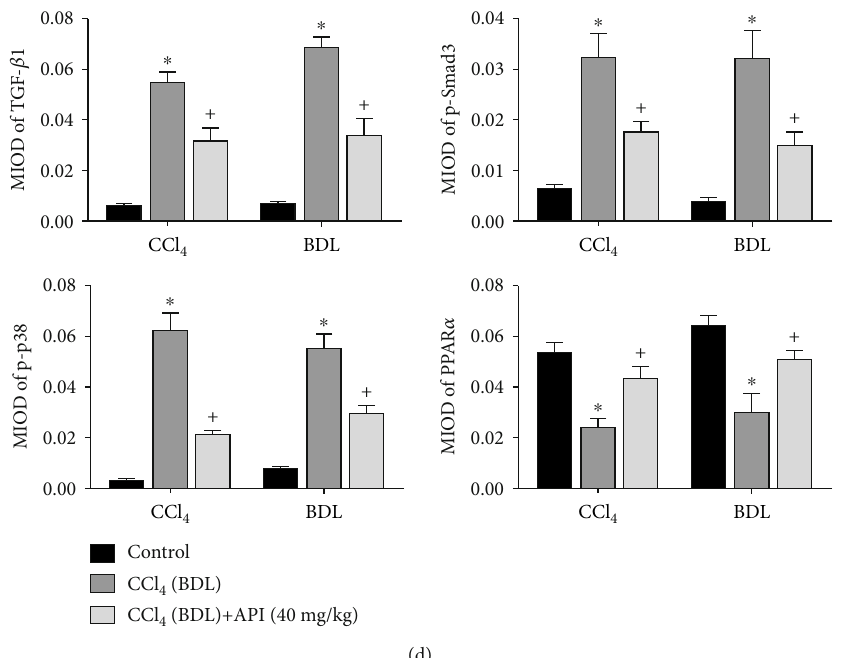
Figure 5: Apigenin could relieve hepatic fi brosis induced by CCl and BDL via downregulating TGF- β 1/Smad3 and p38/PPAR α pathways. 4 Notes: (a) relative TGF- β 1 and PPAR α mRNA levels were determined by qRT-PCR. (b) Western blot analysis of TGF- β 1, Smad3, p-Smad3, p38, p-p38, and PPAR α . (c) TGF- β 1, p-Smad3, p-p38, and PPAR α protein expressions in liver tissues are shown by immunohistochemical staining (200x). (d) Final evaluations were made using Image-Pro Plus 6.0 software to calculate the MIOD of the positive staining area. Data are presented as mean ± SD ( n = 6 ; ∗ P < 0 : 05 for CCl (BDL) group vs. control group; # P < 0 : 05 for CCl (BDL)+apigenin (20 mg/kg) 4 4 group vs. CCl (BDL) group; + P < 0 : 05 for CCl (BDL)+apigenin (40 mg/kg) group vs. CCl (BDL) group; ! P < 0 : 05 for CCl 4 4 4 4 (BDL)+apigenin (40 mg/kg) group vs. CCl (BDL)+apigenin (20 mg/kg) group). Abbreviation: MIOD: mean of integrate optical 4 β 1/Smad3 pathway. The results of qRT-PCR, IHC, and west-